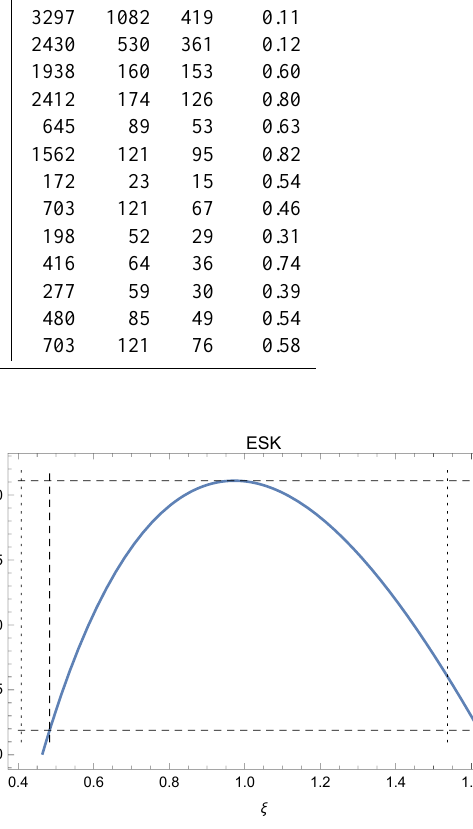
Figure 3. Profile log-likelihood for the ESK station. Likelihood val- ues at maximum and 95% confidence level are indicated by hori- zontal dashed lines. The vertical dashed lines indicate the limits of ξ obtained from the profile. The dotted lines indicate the limits ob- tained by assuming a normal